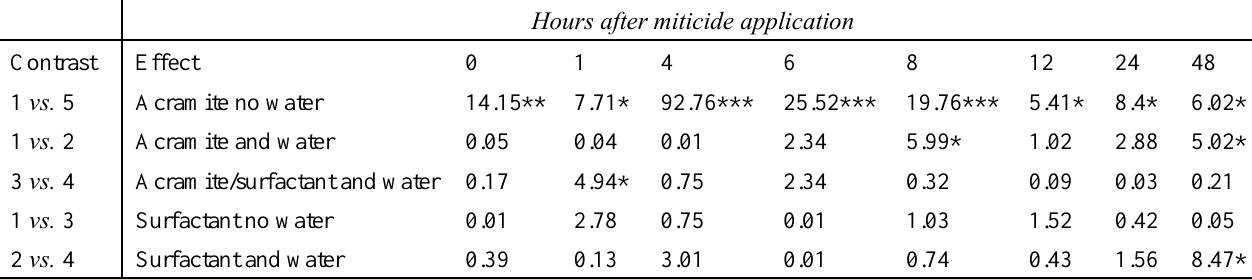
Table 1. F-values from pairwise comparisons of miticide treatments (analysis of